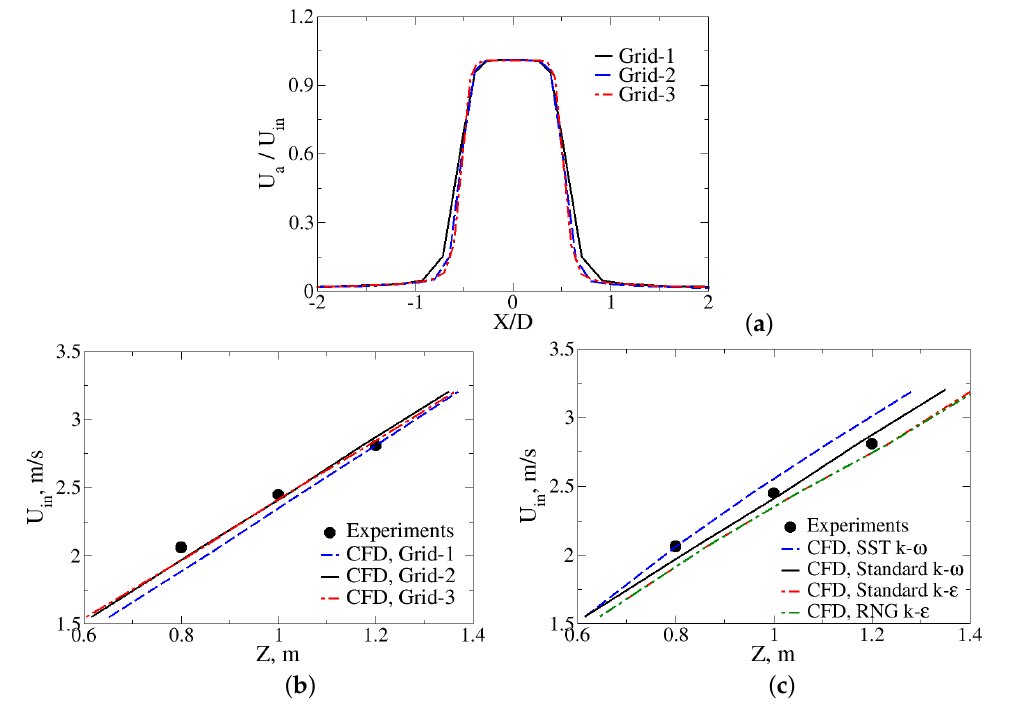
Figure 5. ( a )—radial variation of the dimensional air velocity at Z/D = 3 and Y/D = 0, ( b )—experimental and predicted particle landing position under various inlet velocities for Grid-1 (260,092 cells), Grid-2 (793,244 cells), and Grid-3 (2,445,465 cells); ( c )—experimental and predicted particle landing position under various inlet velocities for different turbulence